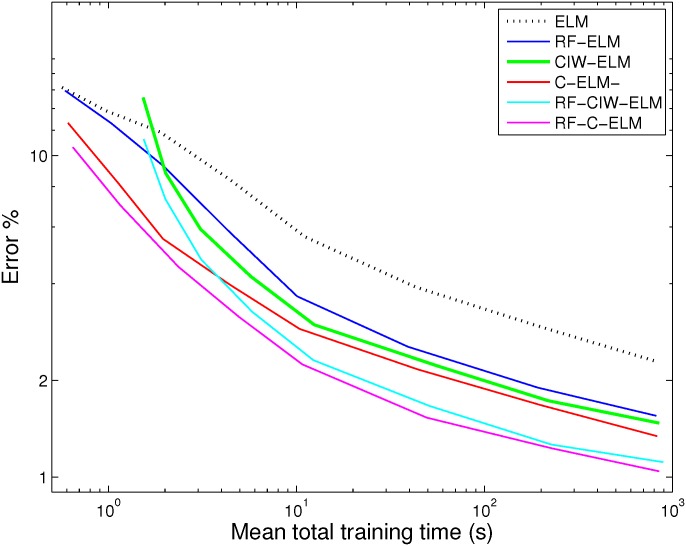
Mean training times for MNIST for various SLFN ELM training methods with shaped input weights.Each trace shows the mean run time from 10 different networks trained on all 60000 MNIST training data points, to achieve the test-date error rates shown in Fig 4. The total time for setup and training are shown, excluding time to load the MNIST data from files. When backpropagation is applied, the runtime scales approximately linearly with the number of iterations, but each backpropagation iteration is slower than each trace shown here, because both input and output weights are updated in each iteration. The time for testing is not included in the figure, but was approximately 10 seconds for M = 12,800, and increases only linearly with M.